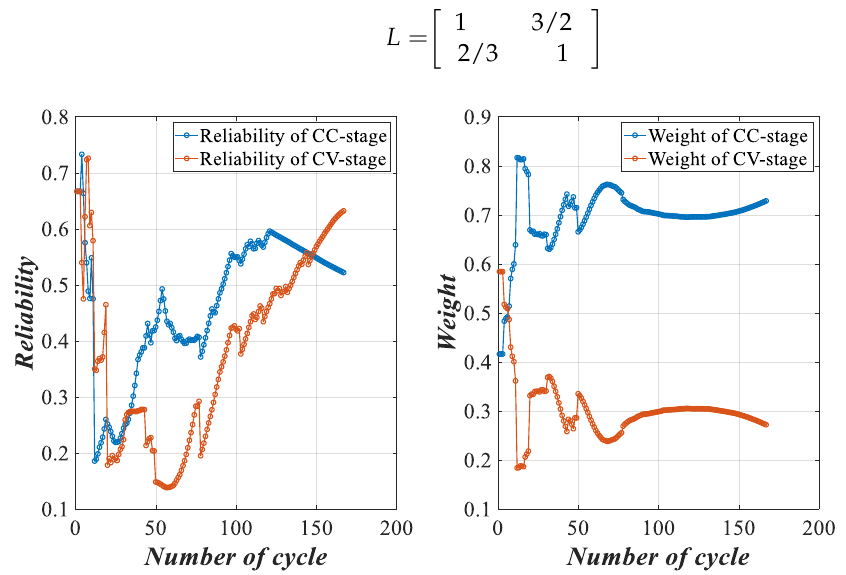
Figure 19. Weight and reliability of the observation indicators in real time.